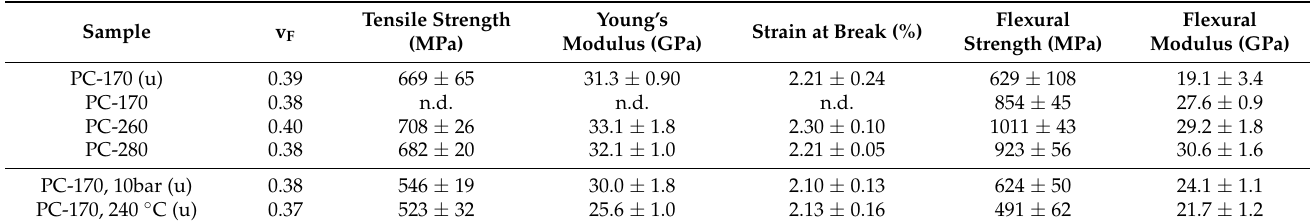
Table 4. Tensile and flexural properties of the UD basalt fibre PC composites.